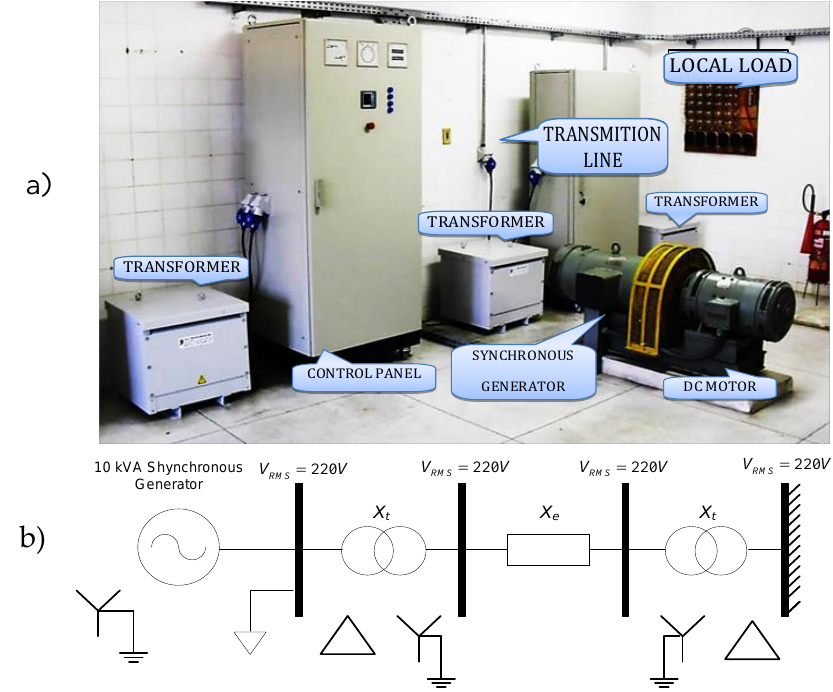
Figure 2. ( a ) Small-scale 10kVA Power System at UFPA; and ( b ) equivalent one-line diagram. Table 1. Small-scale system generation parameters values Resistance and Reactance